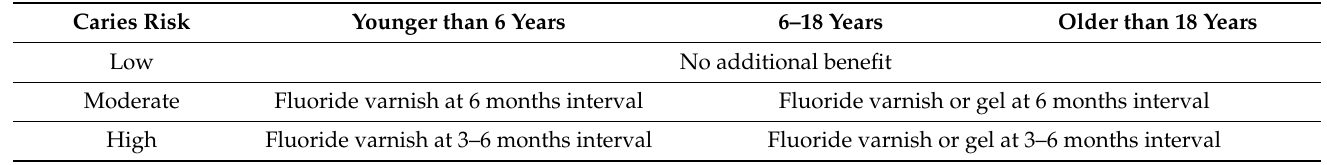
Table 3. Clinical recommendations for the professional application of fluoride varnish and gel.